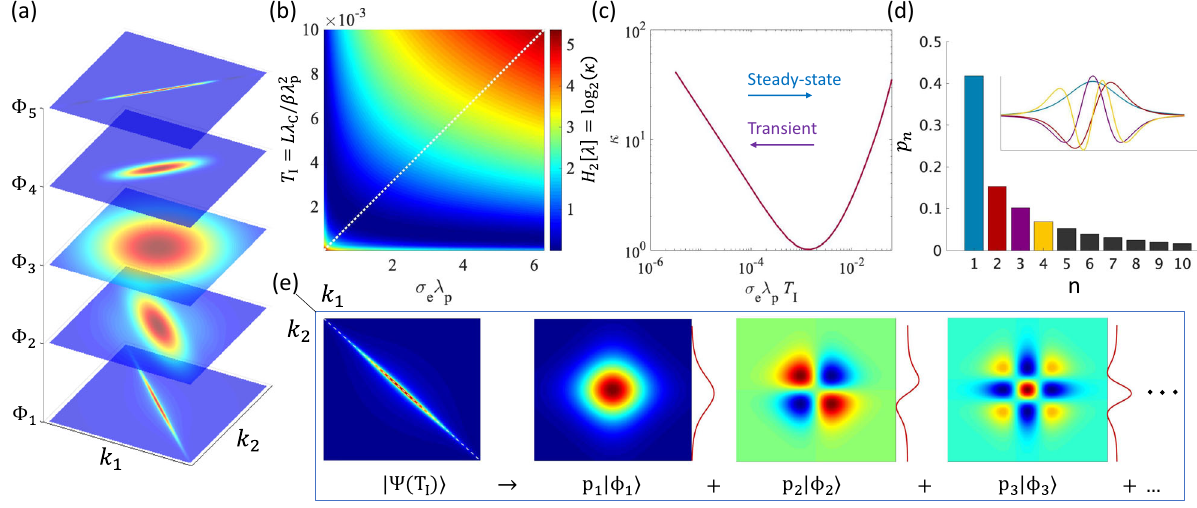
Fig. 2 Entanglement characterization. a The bare pair amplitude Φ λ k 1 ; k 2 ð Þ is presented for selected control-parameter values, covering s 1 ; s 2 the key areas of the dynamical range. The amplitudes labeled Φ i are calculated at the dimensionless interaction times (cid:4) (cid:5) T I ¼ 10 (cid:2) 2 ; 10 (cid:2) 3 ; 10 (cid:2) 5 ; 10 (cid:2) 5 ; 10 (cid:2) 5 2 ; 2 ; 2 ; 1 = 2 ; 1 = 20 ð Þ , respectively. b Collision entropy versus T I and σ e , covering , with bandwidths σ e ¼ 2 π λ p the entire dynamical range from correlated Φ 1 ð Þ to anticorrelated Φ 5 ð Þ momenta. c Variation of the Schmidt number κ along the dotted curve displayed in b , exposing the short time mode meshing of narrow-band electrons. d Schmidt spectrum of the amplitude displayed in e κ (cid:3) 6 ð Þ . The corresponding eigenstates are displayed in the inset with matching colors. e Pair amplitude in joint momentum space, where we display the fi rst (lowest order) three